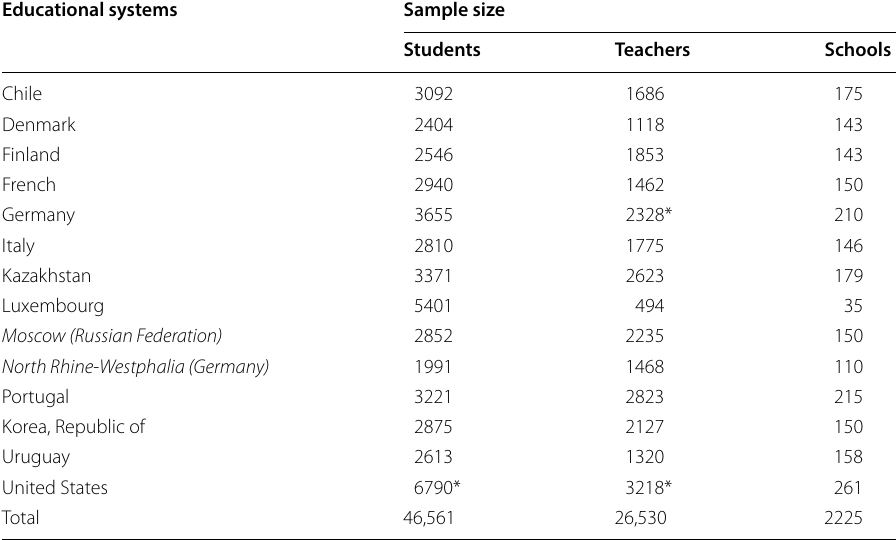
Table 1 Summary of sample sizes (N) differentiated by group of persons and education